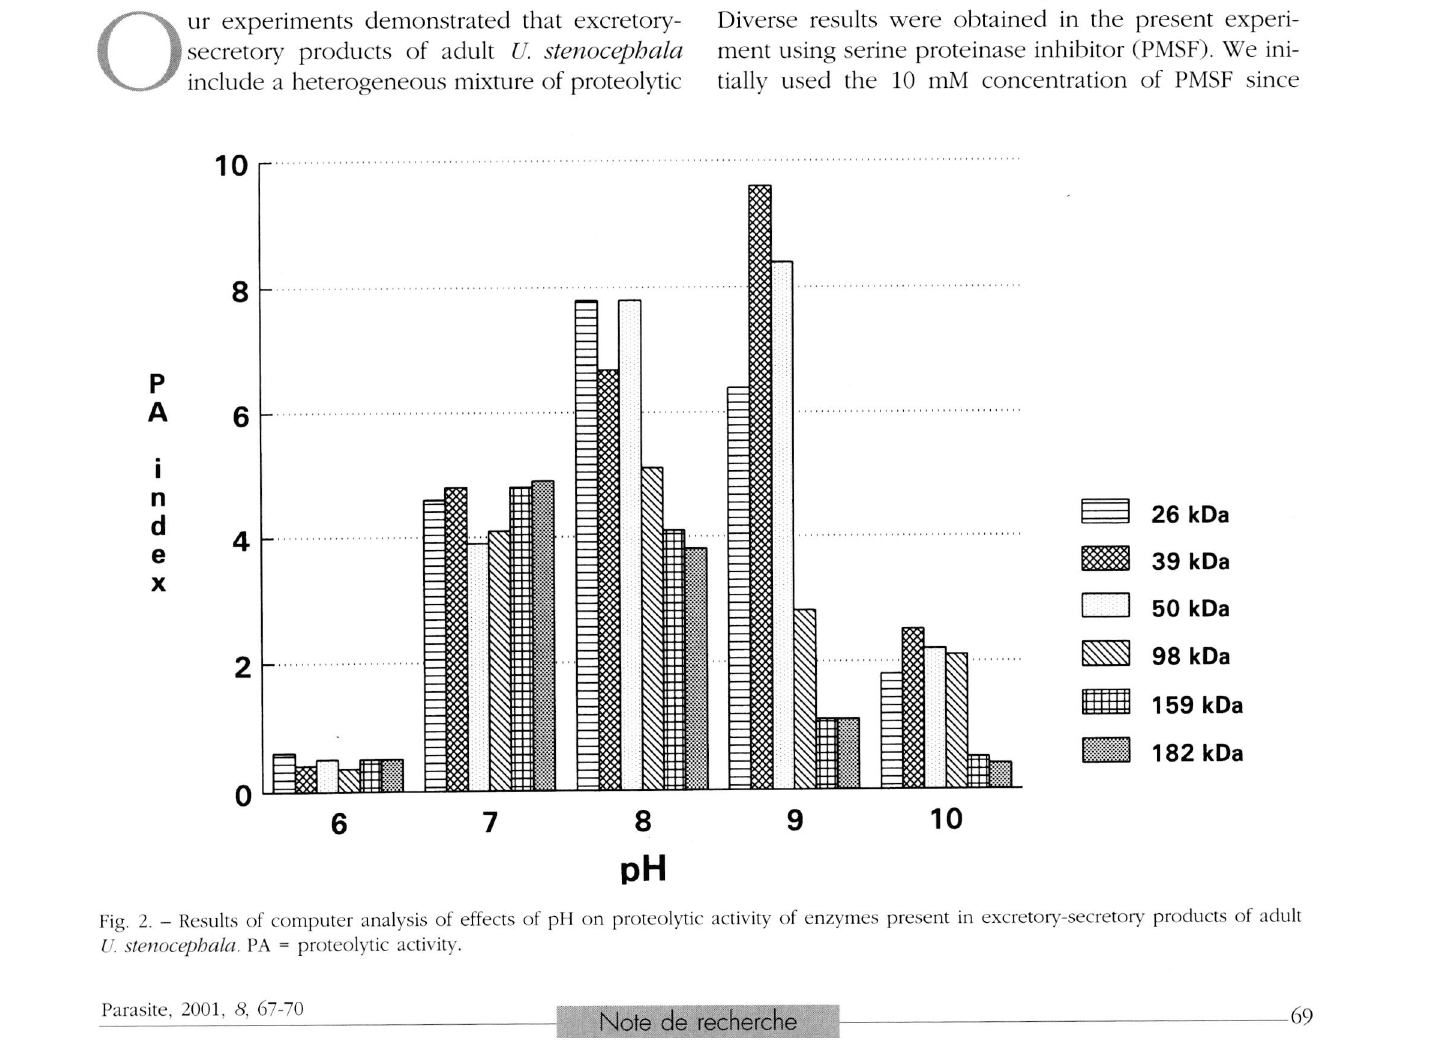
Fig. 2. - Results of computer analysis of effects of pH on proteolytic activity of enzymes present in excretory-secretory products of adult U. stenocephala. PA = proteolytic